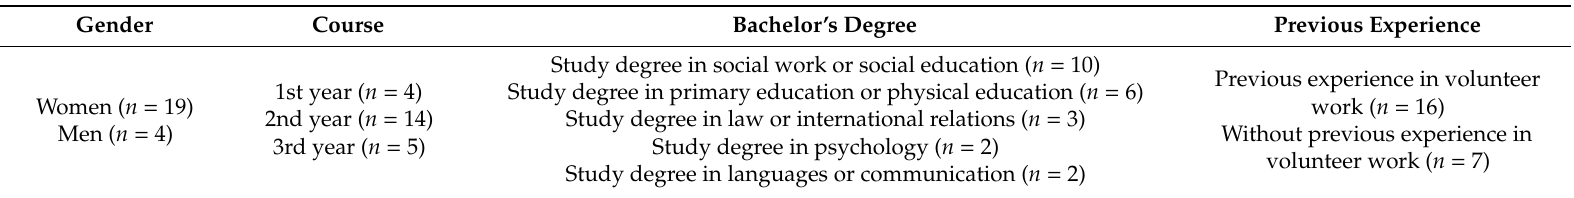
Table 1. Characteristics of the sample. Distribution of the sample by gender, degree, and course studied and previous experience in